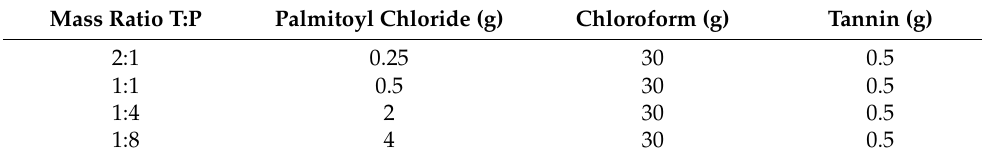
Table 3. Different compositions used to produce oil-grafted tannin using palmitoyl chloride.